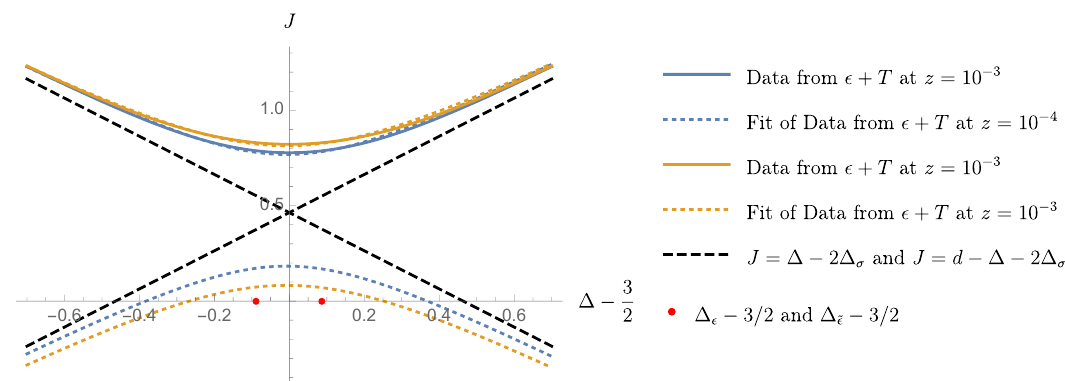
Figure 13 . The interpolation of data points and their fit for two sets of points considered in figure 12 is given. The analytic continuation is obtained once the fit is found. The (cid:15) and its shadow are represented by the two red dots. We see the prediction for ∆ (cid:15) by looking at the intersection of the curves and the ∆